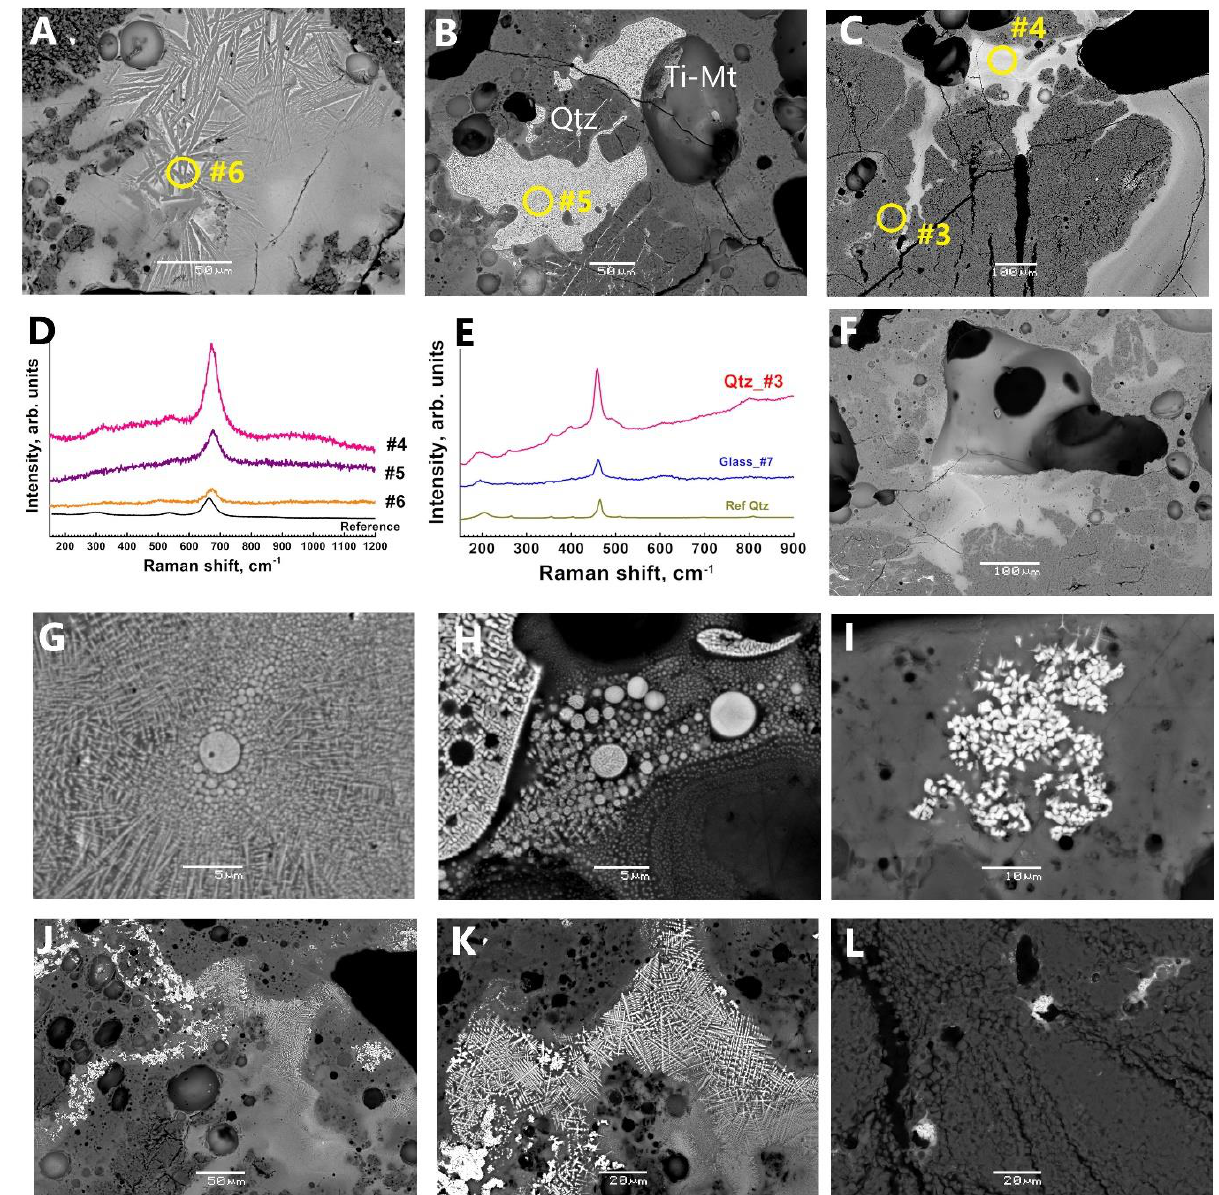
Figure 6. Structural peculiarities of the outer glassy shell of the Kh-7b sample. ( A – C , G-K ) SEM-BSE images of the Fe-enriched phases (white color) of different morphology; ( B , C ) crystal phases formed after incongruent melting of alkaline amphibole: Qtz — quartz, Mt — magnetite. Yellow circles show spots where Raman spectra ( D , E ) were recorded: #3 — quartz grain ( C ); #4 — Fe-enriched glass in a quartz crack ( C ); #5 — Ti-magnetite ( B ); #6 — magnetite in devitrified glass ( A ). ( D , E ) Raman scattering spectra of Fe-enriched phases (D), quartz grain and matrix of the aluminosilicate core ( E ). The references are from Rruff database [44]. ( F ) Interconnected porosity; ( G , H ) liquation texture; ( I ) pseudobrookite (Fe 2 TiO 5 ) crystals in anorthite; ( J ) exsolution of Fe-oxides; ( K ) magnetite dendrites (zoomed region from ( J )). ( L ) Sintered sand in the central part of the Kh-7 sample. White spots — former mineral inclusions.